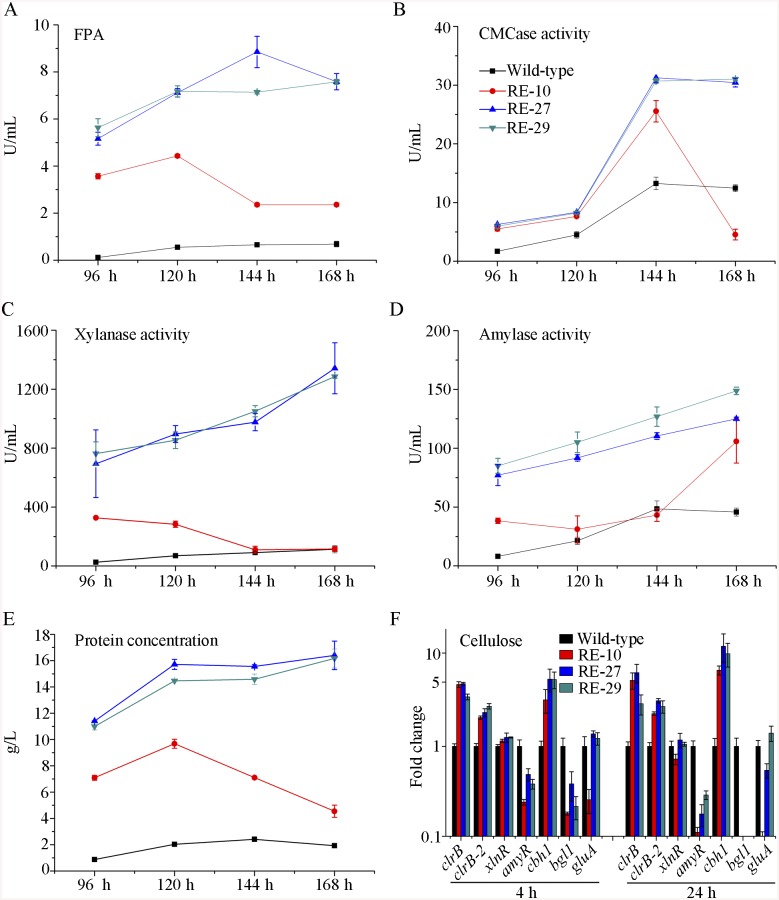
Overexpression of clrB or xlnR in triple-mutant RE-10 enhanced hydrolase expression under inducer-inducing conditions.(A-E) The FPA, pNPCase activity, xylanase activity, amylase activity and total secreted protein concentration of culture supernatants from RE-27 (Δbgl2-ΔcreA-gpdA(p)::clrB-PDE_02864(p)::clrB) and RE-29 (Δbgl2-ΔcreA-gpdA(p)::clrB-PDE_02864(p)::xlnR) mutants versus the wild-type and triple-mutant RE-10 (Δbgl2-ΔcreA-gpdA(p)::clrB) were separately evaluated when grown on wheat bran medium in flasks. (F) q-PCR measurements of clrB, clrB-2, xlnR, amyR, cbh1, bgl1 and gluA expression in RE-27 and RE-29 mutants versus the wild-type and RE-10 strains on cellulose. Expression levels were normalized to the wild-type.